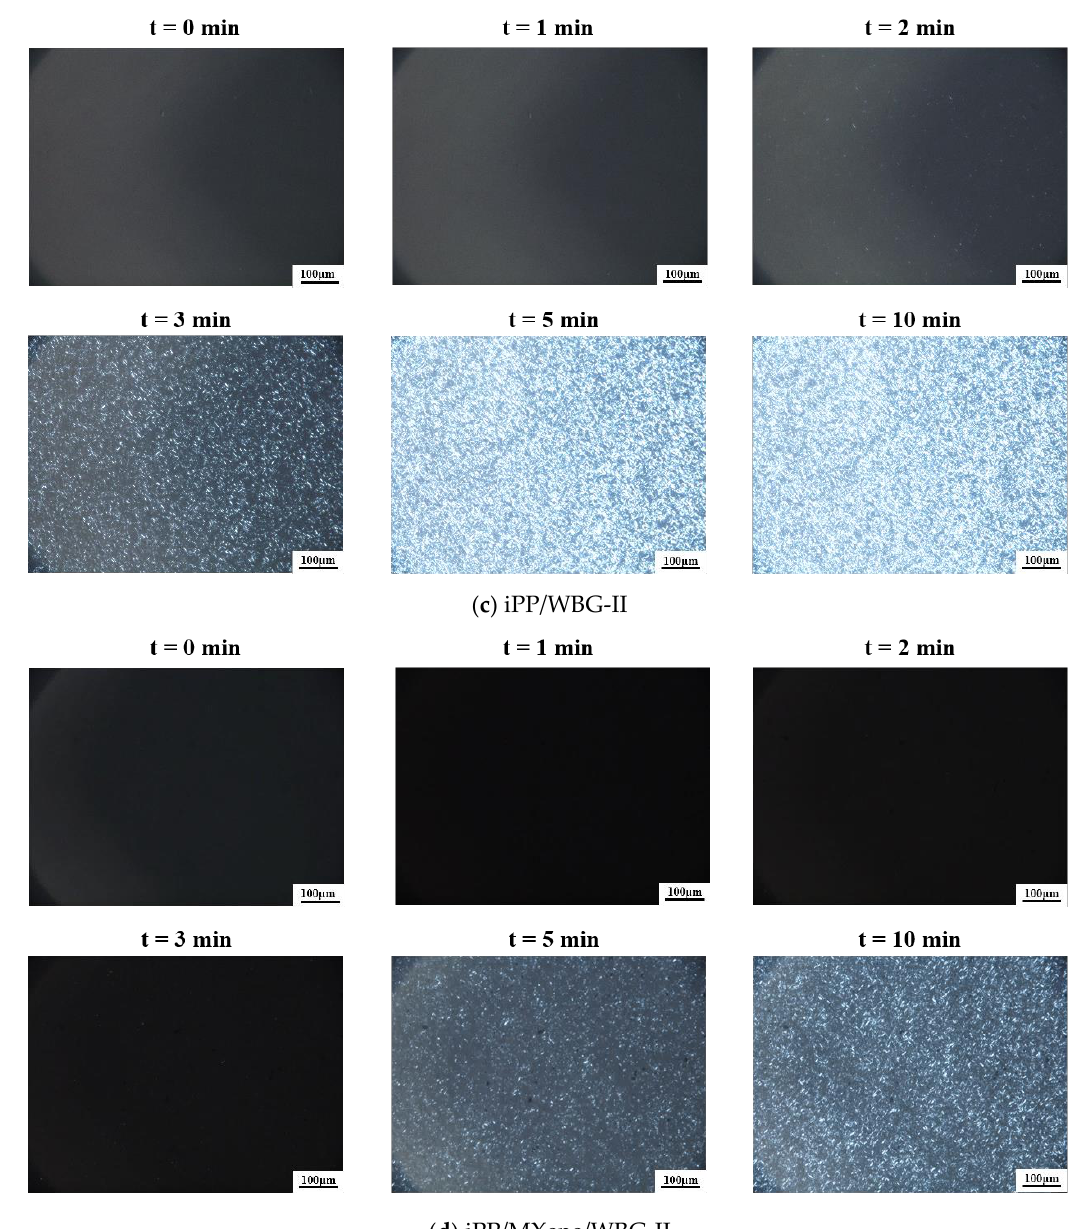
Figure 10. Crystallization morphological evolution during isothermal crystallization of ( a ) neat iPP ( b ) iPP/MXene ( c ) iPP/WBG-II and ( d ) iPP/MXene/WBG-II at 140 °C. The bar represents 100 μm.